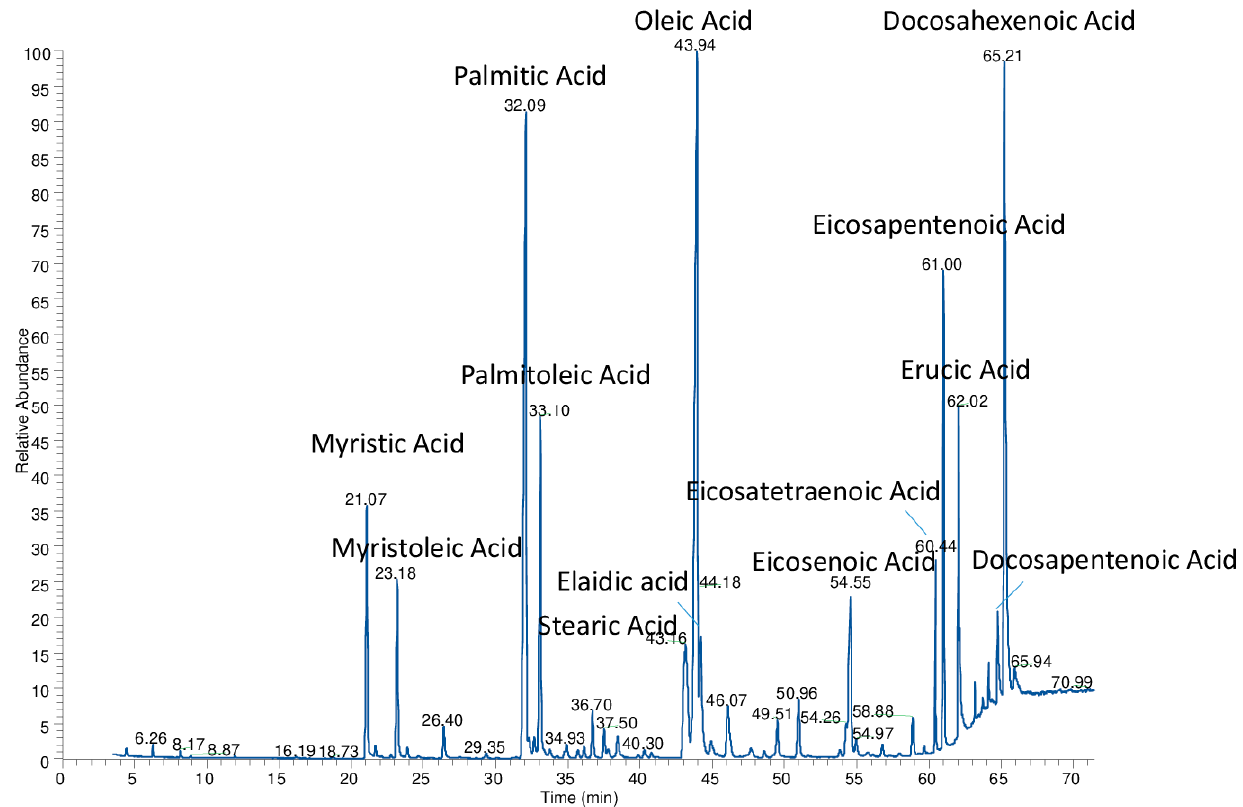
Figure 2. GC/MS chromatogram of fatty acid methyl esters (FAMEs) obtained from tuna fish oil. Table 1. Fatty acid composition of tuna fish oil determined by independent